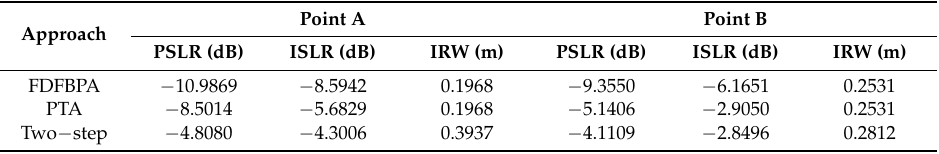
Figure 9. Azimuth pulse response curve comparison of FDFBPA, PTA and Two-step MOCO. ( a ) Scatter Point A; ( b ) Scatter Point B.